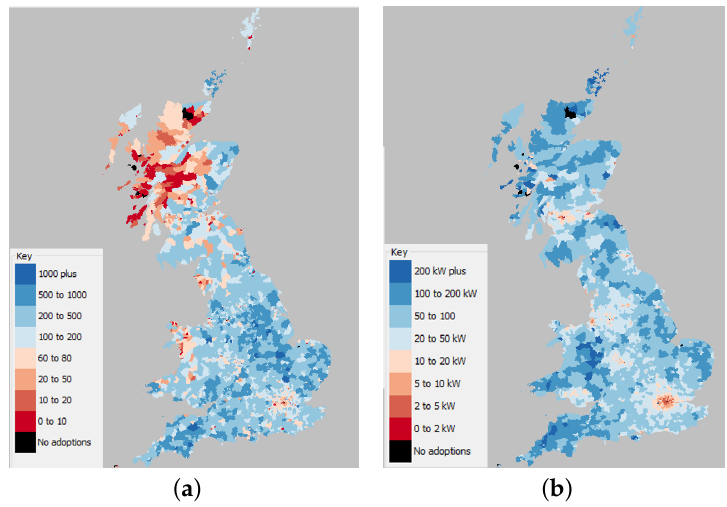
Figure 2. Spatial distribution of domestic PV installations on 30 September 2015. ( a ) Installation count (per (A) in Section 3); ( b ) Capacity per thousand population per (D) in Section